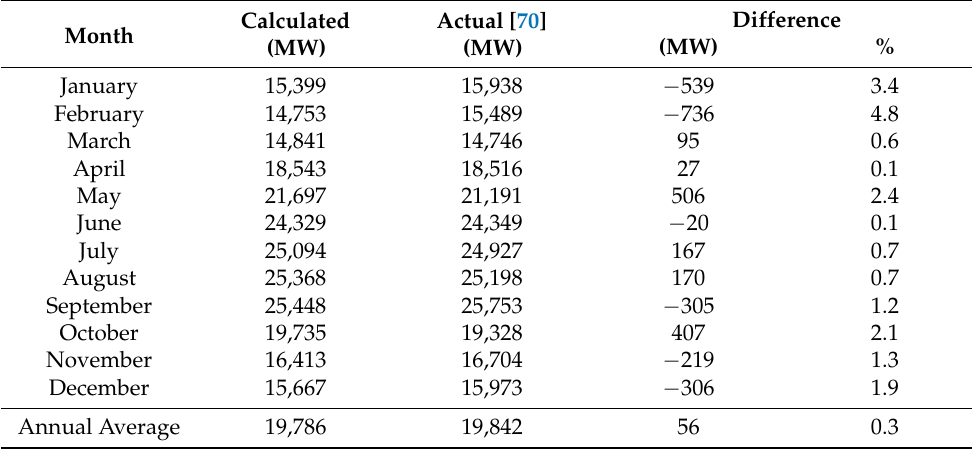
Table 6. Electricity demand validation—average monthly power